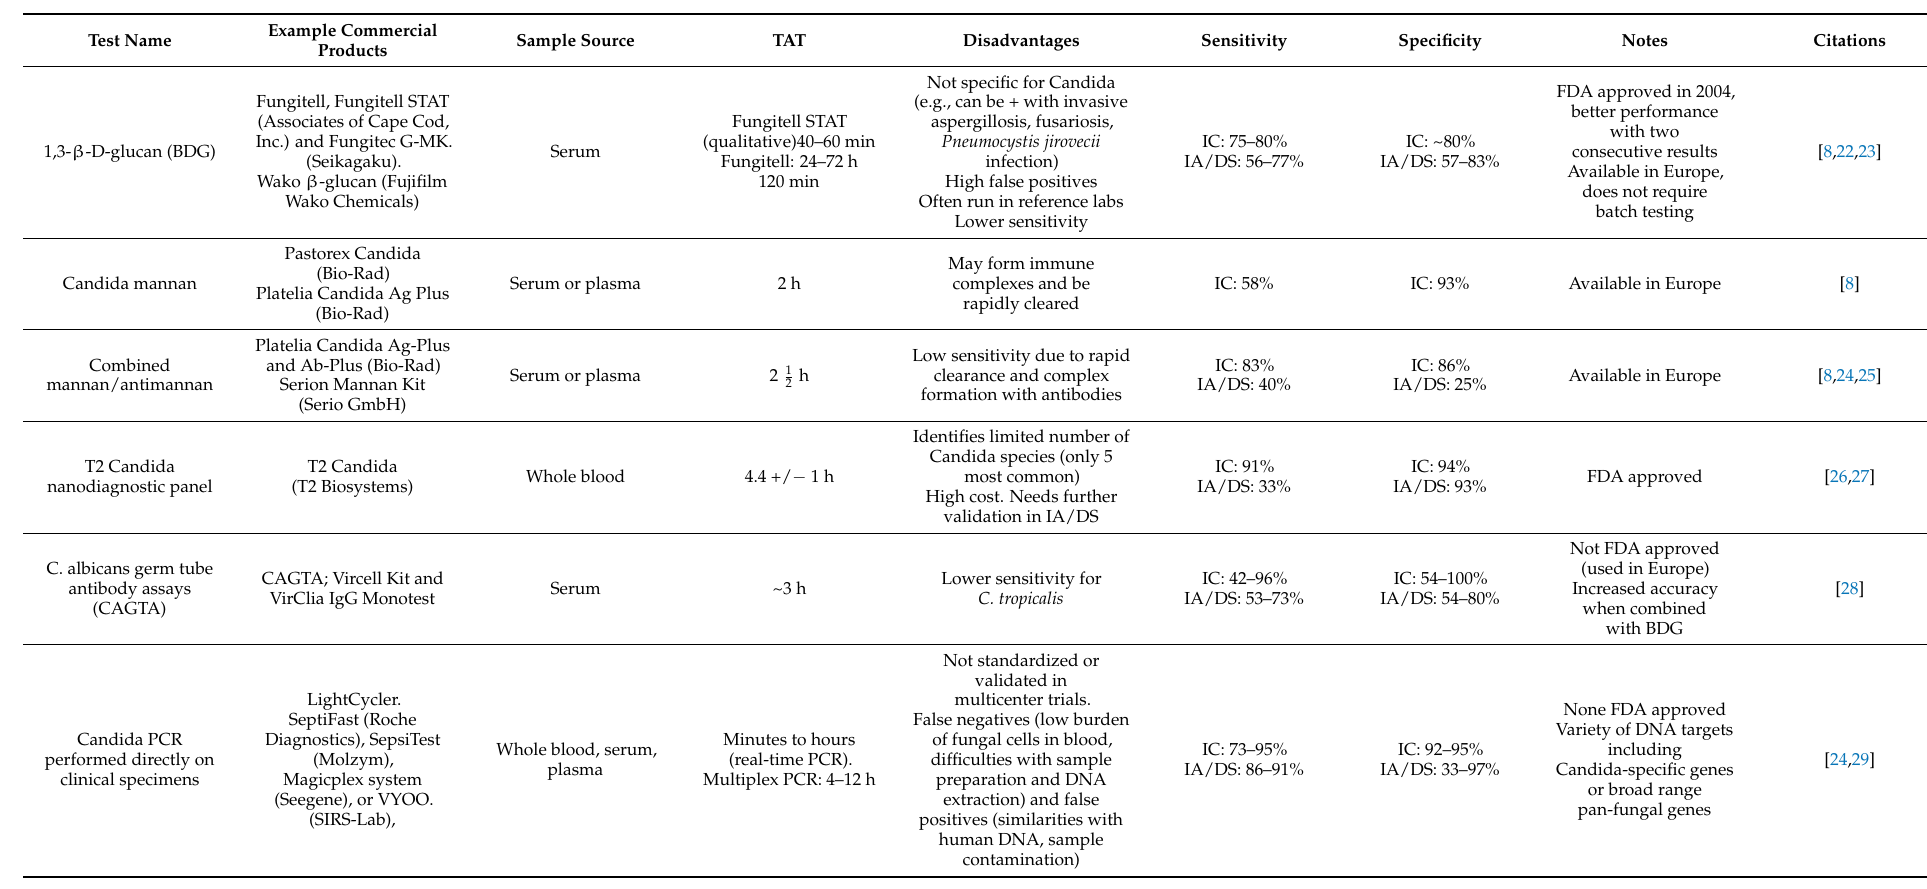
Table 1. Commercially available blood culture-independent diagnostic modalities for detecting Candida sp. IC: invasive candidiasis. IA: intra-abdominal. DS: deep